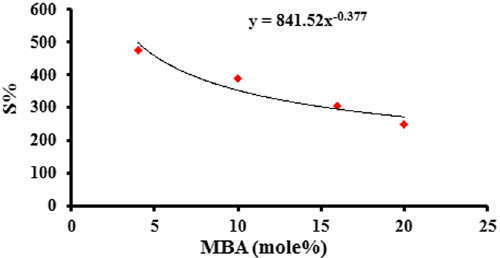
Fig. 5 Swelling changes in samples 5–8 versus MBA mole percent- age at the swelling time of 180